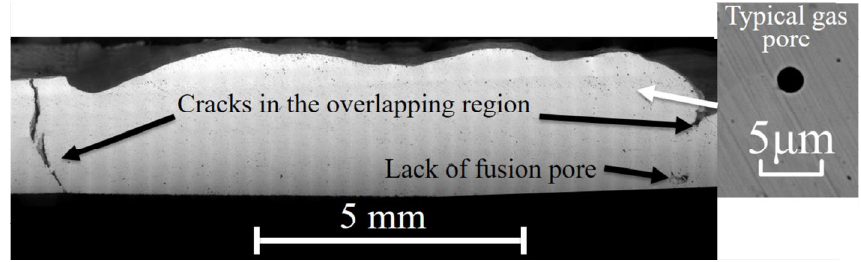
Figure 11. The defects formed at the overlapping region of the 10I:0/90R0 part.